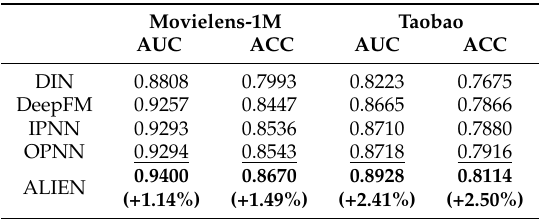
Table 6. AUC and ACC scores for the ALIEN models and the baselines for the test sets in Movielens-1M and Taobao